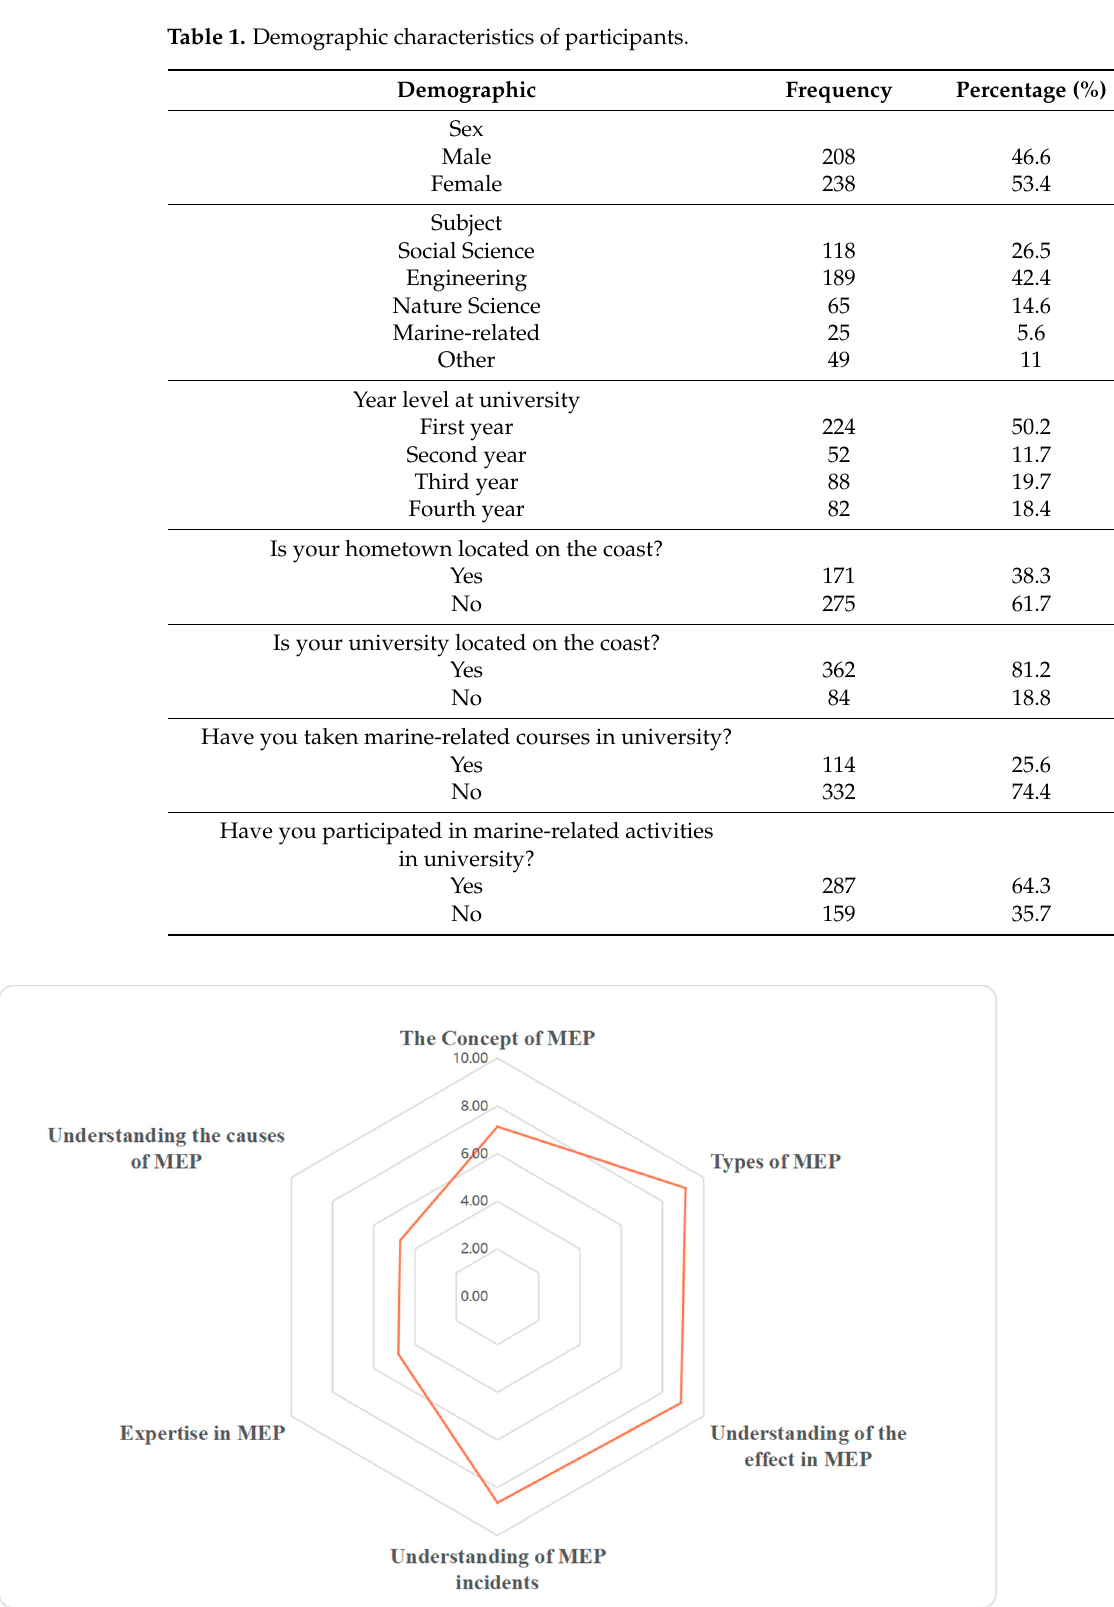
Figure 1. University students’ knowledge about marine environment pollution (MEP).